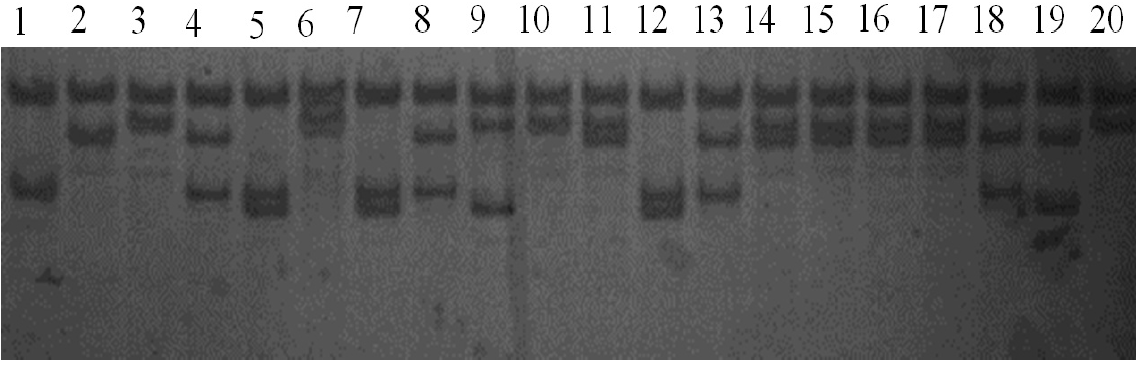
Figure 1. Electrophoresis patterns of exon 2 of the growth hormone (GH) gene of Huoyan goose obtained by polymerase chain reaction-single strand conformation polymorphism (PCR-SSCP). Band 1: genotype BB; Band 2: genotype CC; Bands 3, 6, 10 and 20: genotype DD; Bands 4, 8, 13 and 18: genotype BC; Bands 5, 7 and 12: genotype AB; Band 9: genotype AD; Bands 11, 14, 15, 16 and 17: genotype CD; Band 19: genotype